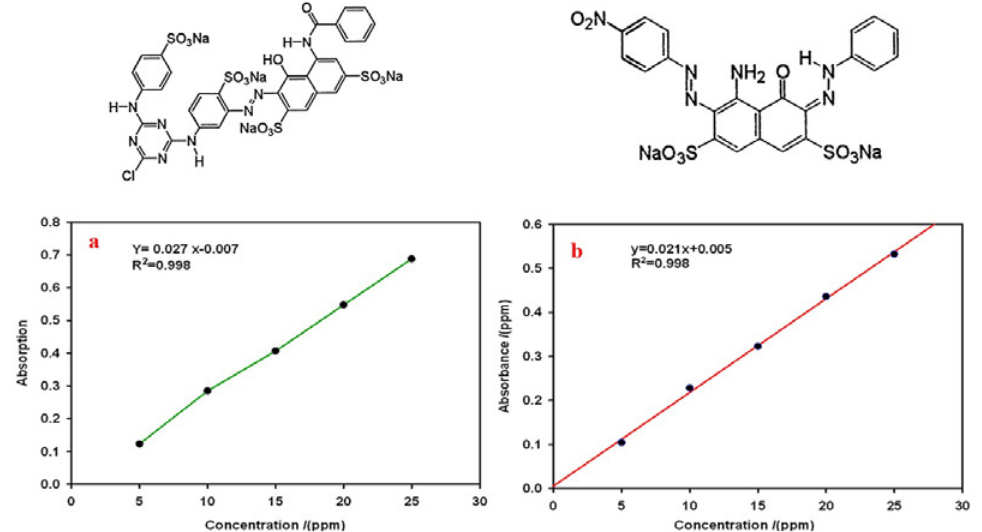
Fig. 3. The Concentration dependent spectra from different standard solutions and calibration curves: a) Reactive Red 4 and b) Acid Black